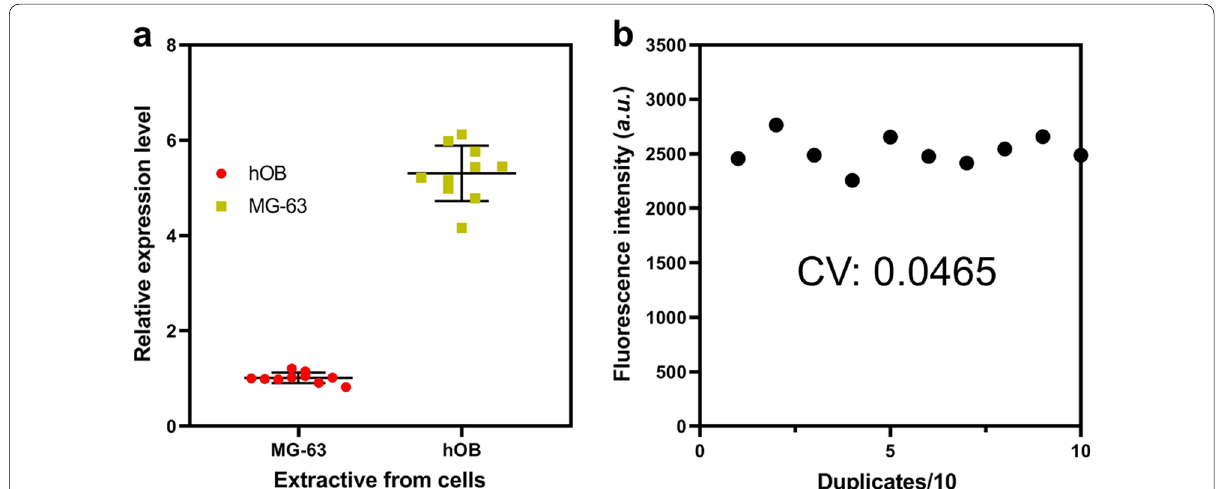
Fig. 4 Clinical application of the approach. a Relative miRNA-21 expression level in MG-63 cell extractive and in hOB cell extractive. b Fluorescence intensity of the approach when detecting 10 sample duplicates (concentration of miRNA-21: 1